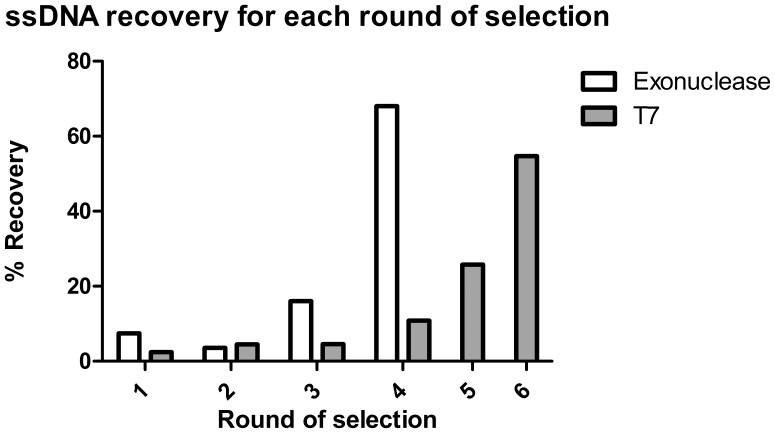
Percentage recovery of ssDNA using different SELEX methods.Both exonuclease- and T7-based methods were used to generate ssDNA, and counter-selection was preformed after round 3 (exonuclease-based SELEX) and 5 (T7-based SELEX).